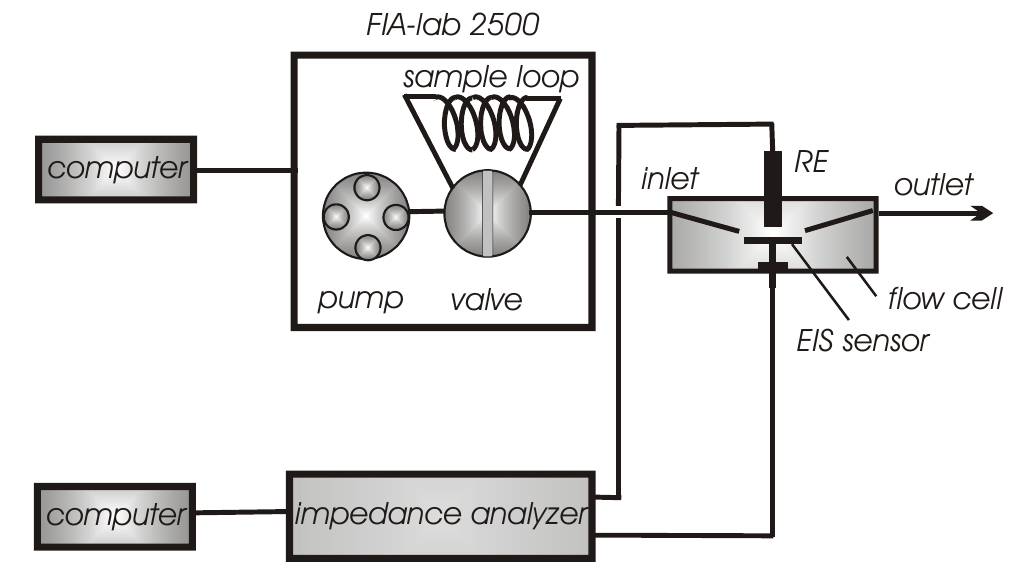
Figure 1. FIA measuring system (schematically); RE: reference